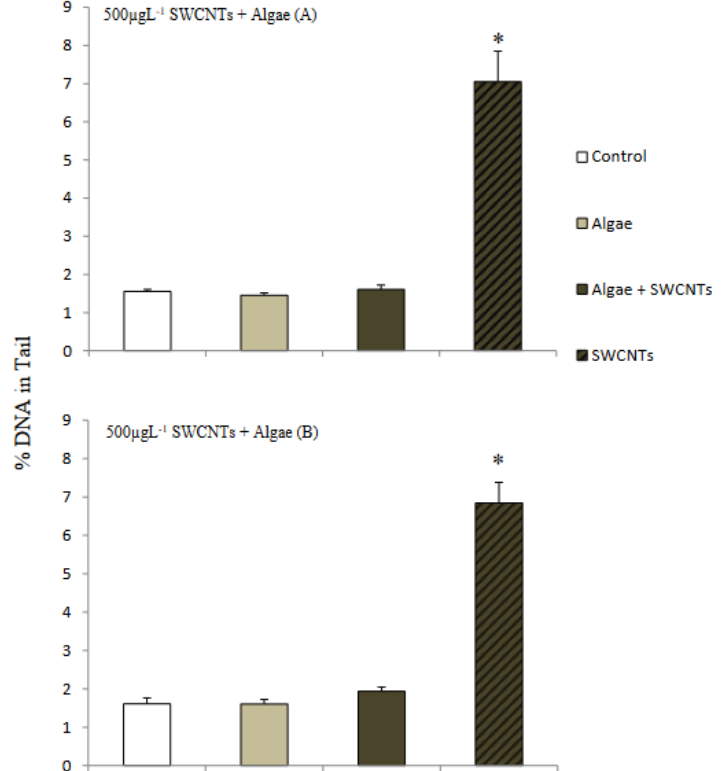
Figure 13. Mean ( ± SD) DNA strand breaks (Comet assay) in mussel ( A ) haemocytes and ( B ) gills after feeding on algae ( Tetraselmis suecica ), SWCNT 500 µ g L − 1 alone and Tetraselmis suecica + SWCNTs 500 µ g L − 1 for 24 h. * significantly different from control, algae and algae + SWCNTs 500 µ g L − 1 (One Way ANOVA: F = 1.83, df num = 3, means ± SD; n = 3; p < 0.001).